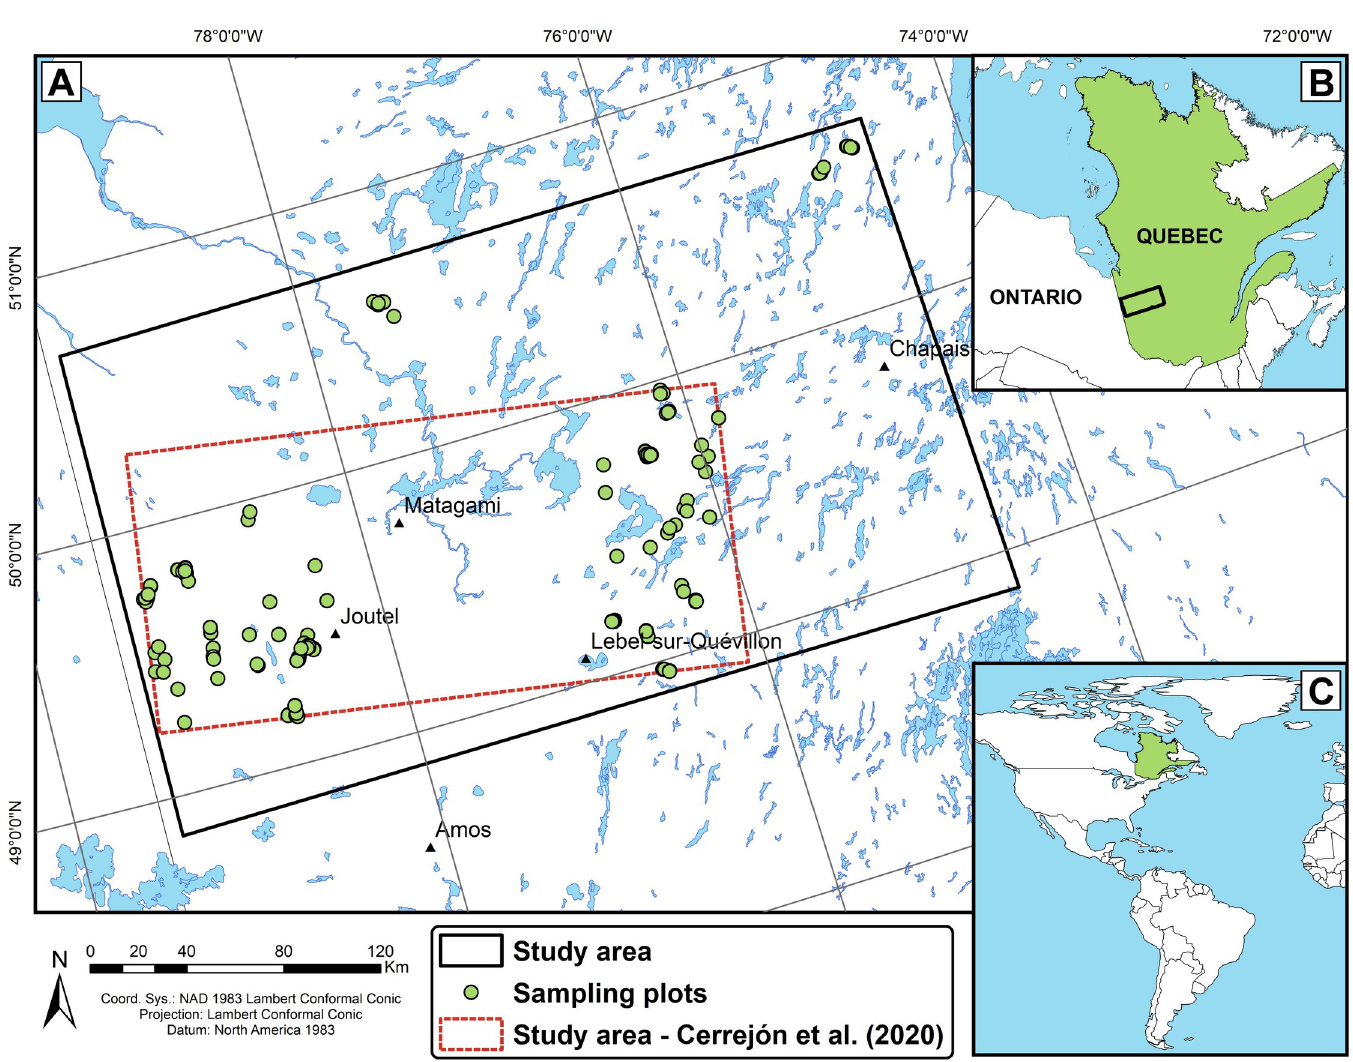
Fig 1. A: Study area and sampling plots (n = 389) in the boreal black spruce forest of western Quebec. B: Location of the study area within Quebec. C: Location of Quebec (eastern